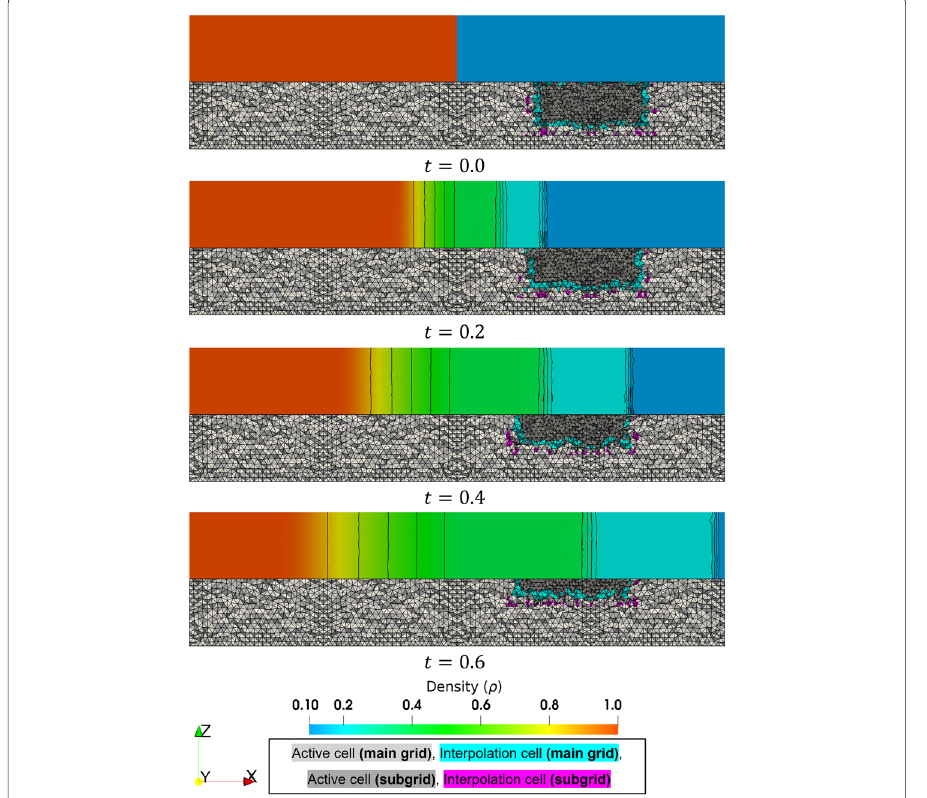
Fig. 8 Flow field at each time step (shock tube